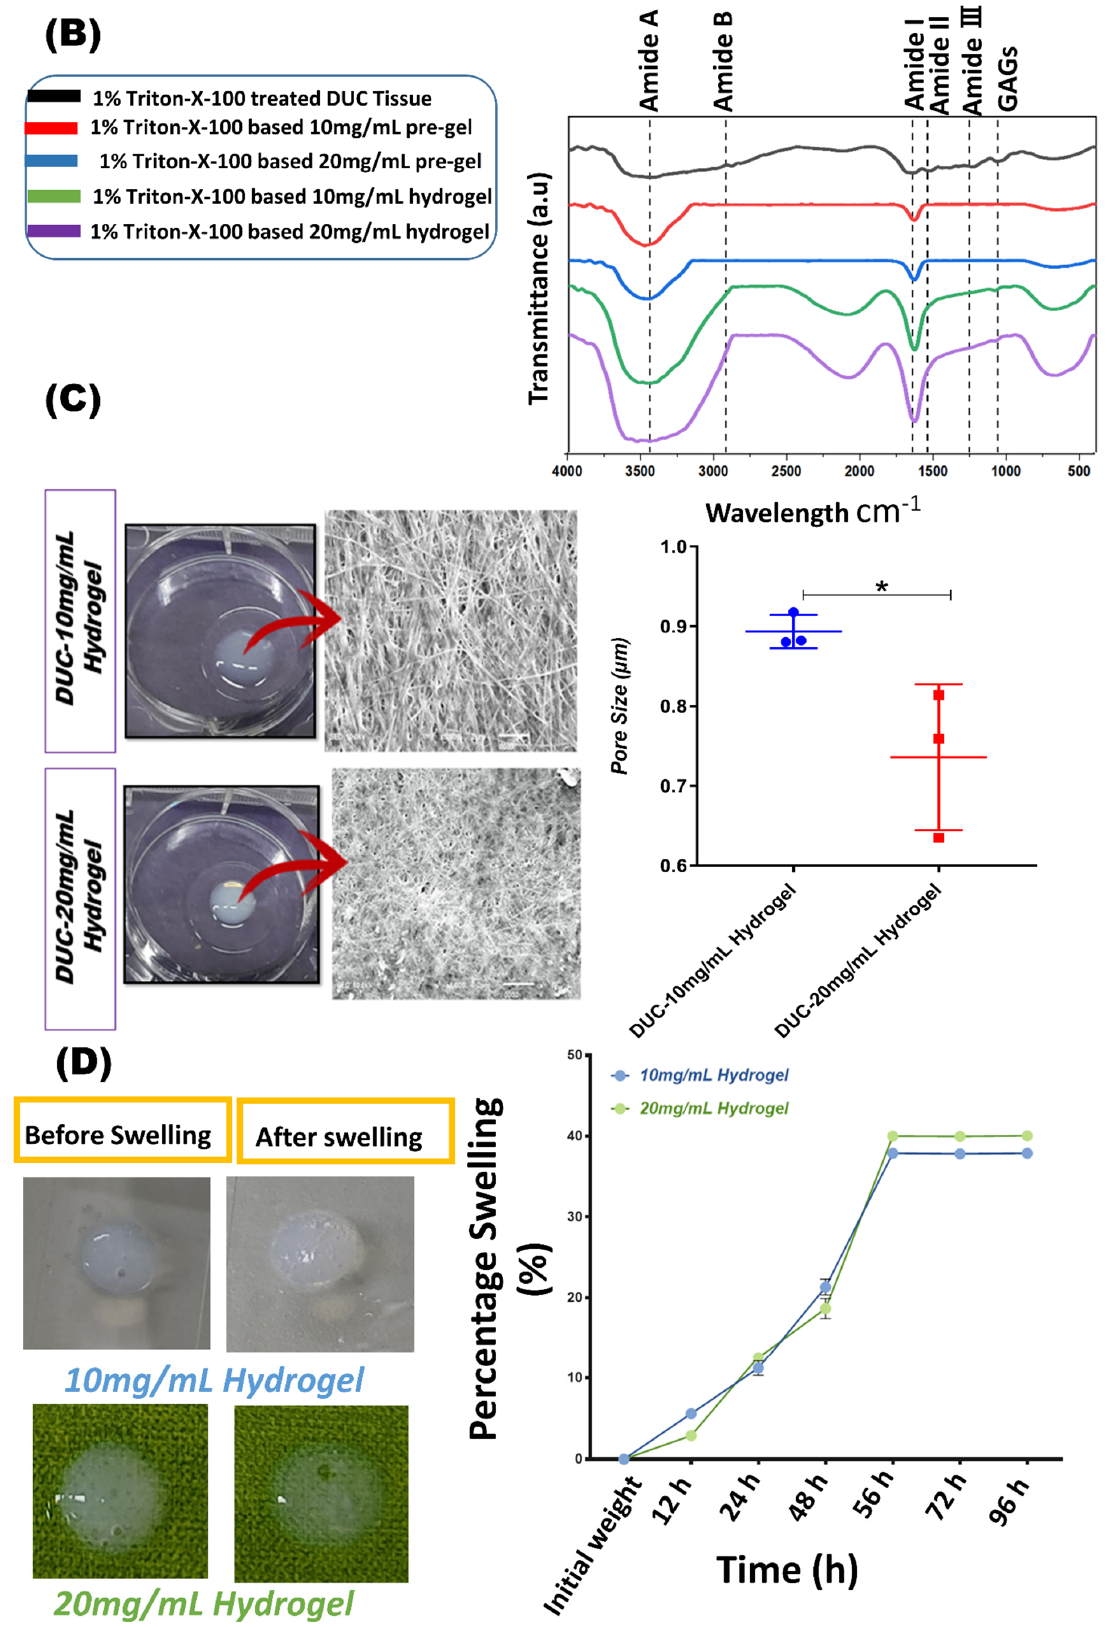
Figure 4. Schematic representation of decellularized tissue hydrogel (3D scaffold) and its biochemical and structural analysis: ( A ) Decellularized samples were lyophilized in a freeze dryer ( a ). The